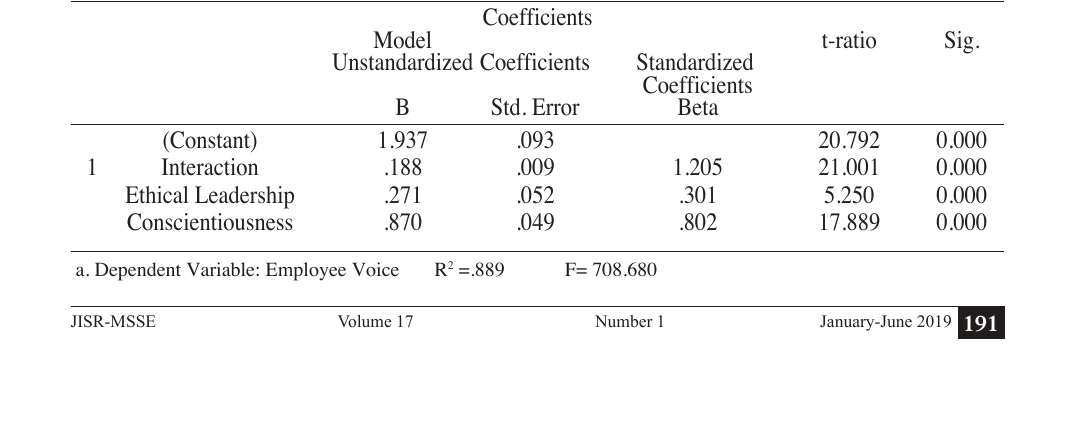
Table 8 Moderation Effect of Conscientiousness on the Relationship of Ethical Leadership and Employee